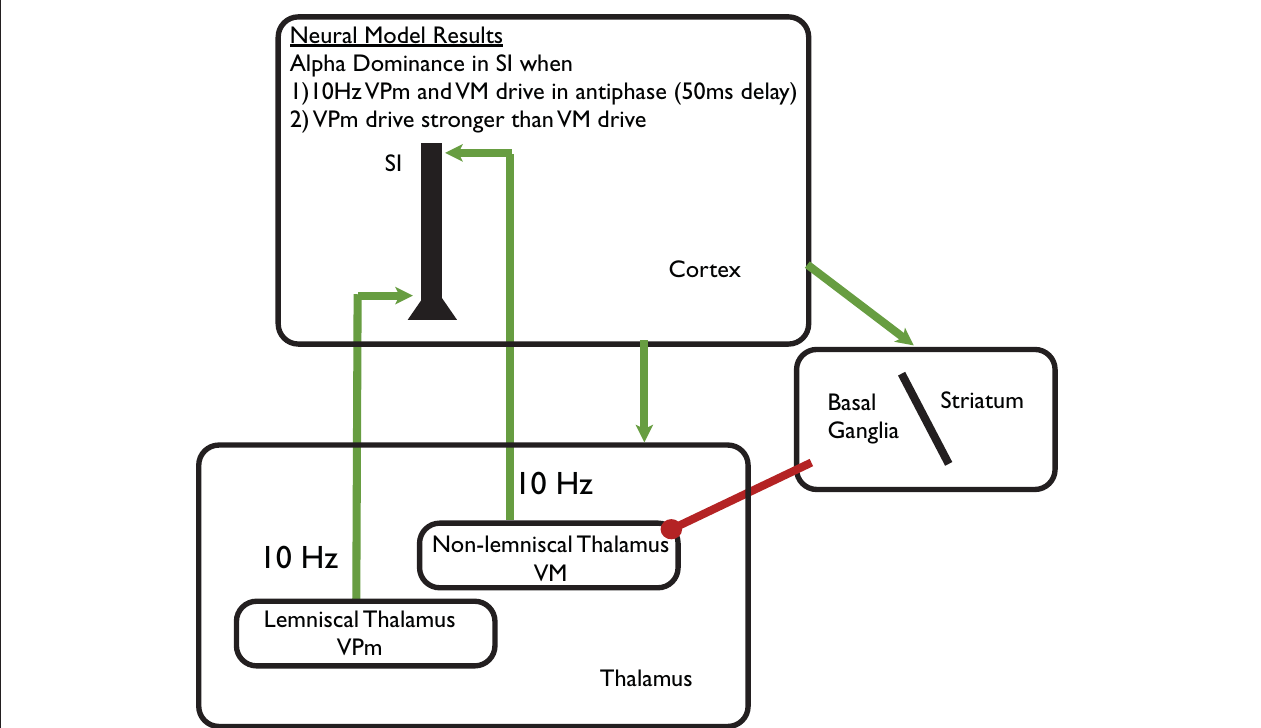
FIGURE 4 | Schematic illustration of computational neural modeling predictions on the origin of alpha. Green arrows represent excitatory synaptic connections and red circles inhibitory synaptic connections. We hypothesize that focal changes in alpha can be achieved by modulation of the lemniscal thalamic Ventral-Posterial medial (VPm_) pathway to SI, while diffuse regulation can be achieved through modulation of non-specific Ventral-Medial (VM) thalamic drive. The VM thalamic nucleus